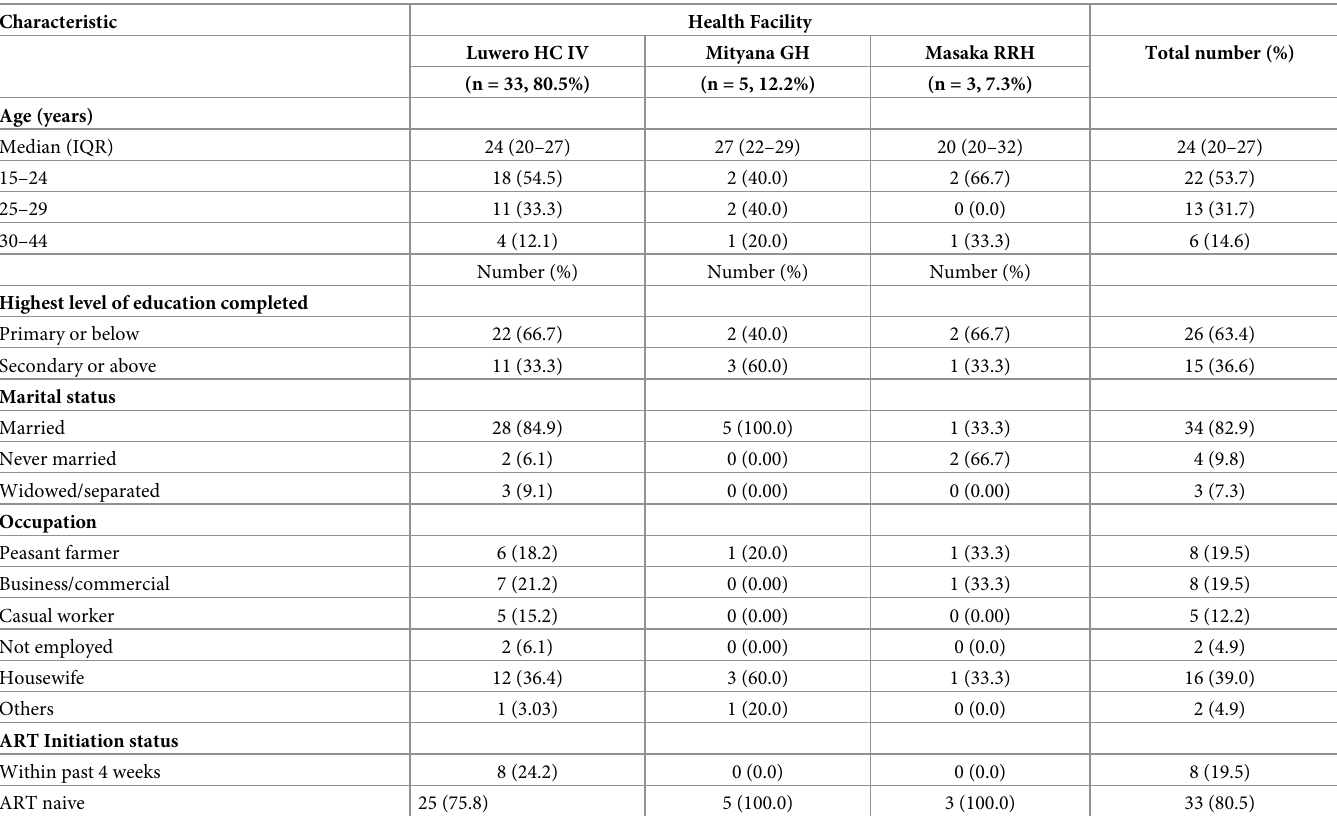
Table 2. Baseline characteristics of HIV positive pregnant women who declined to participated in the study (N = 41) by health facility.